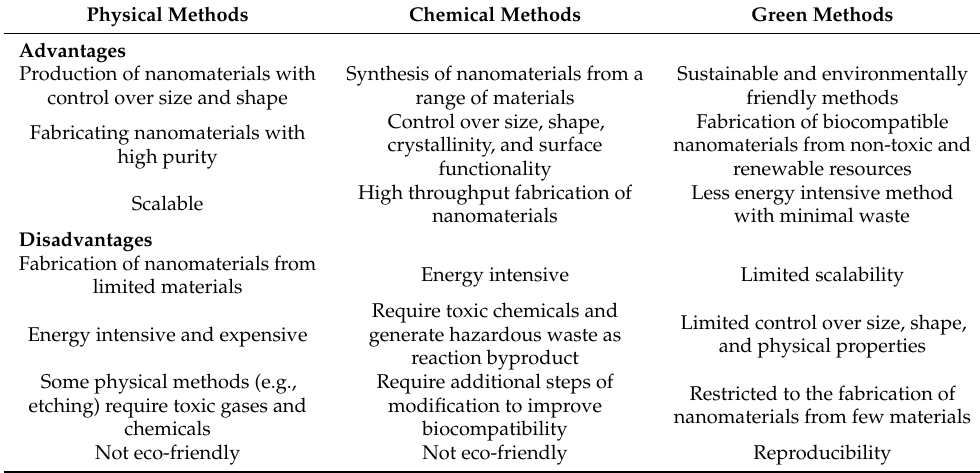
Table 1. Advantages and disadvantages of physical, chemical, and green